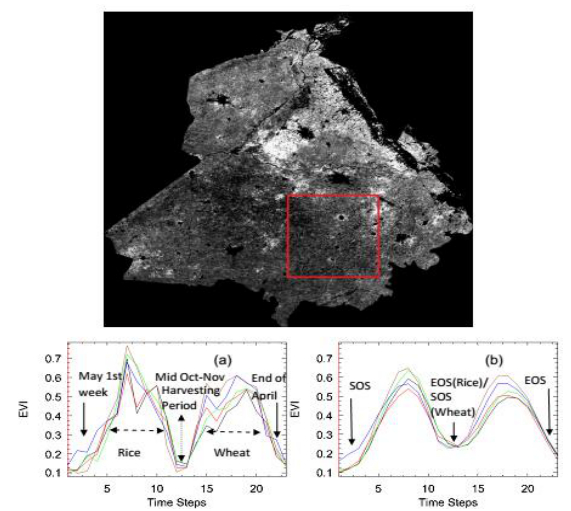
Figure 2. Time series EVI profile (spectra) of selected locations in the red bounding box. The lower left panel (a) shows